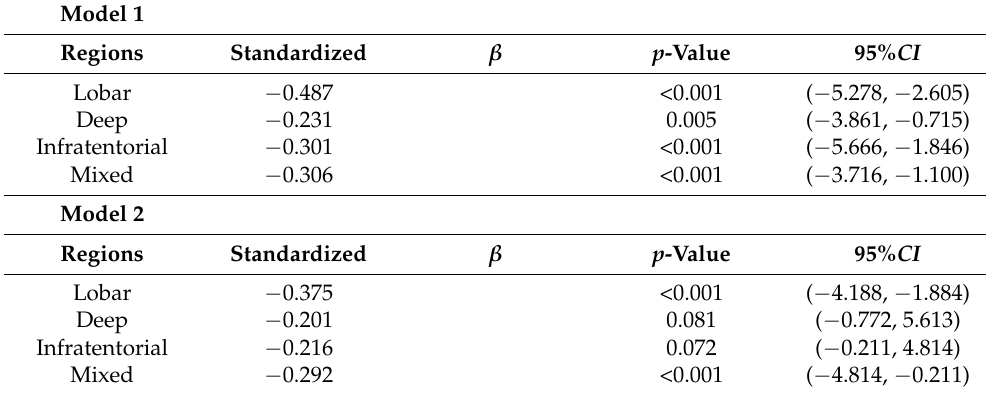
Table 8. The relationship between CMBs in different regions and MoCA scores.